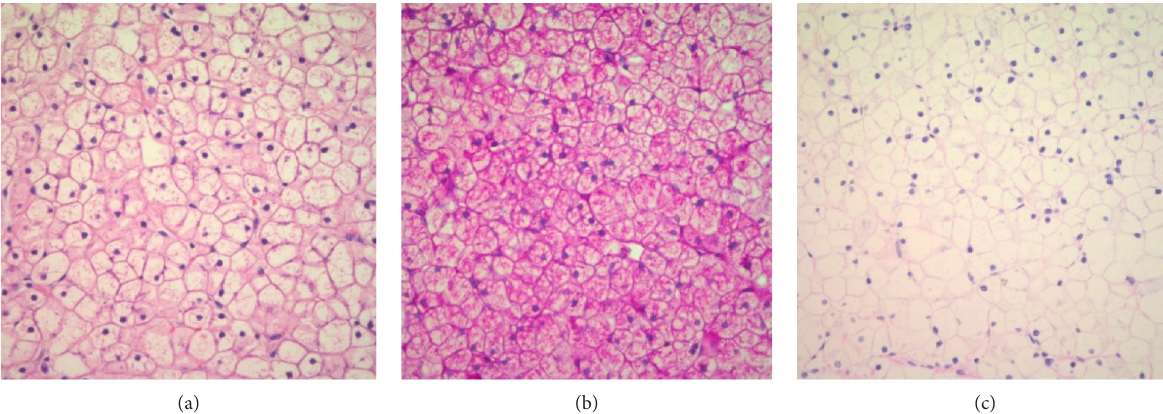
Figure 1: (a) Hemotoxylin and eosin (H&E) stain showing enlarged and distended hepatocytes with clear cytoplasm. (b) Periodic acid- Schiff (PAS) stain showing increased glycogen content in the cytoplasm of hepatocytes. (c) Periodic acid-Schiff-diastase (PAS-D) stain showing the removal of glycogen from hepatocytes with the diastase